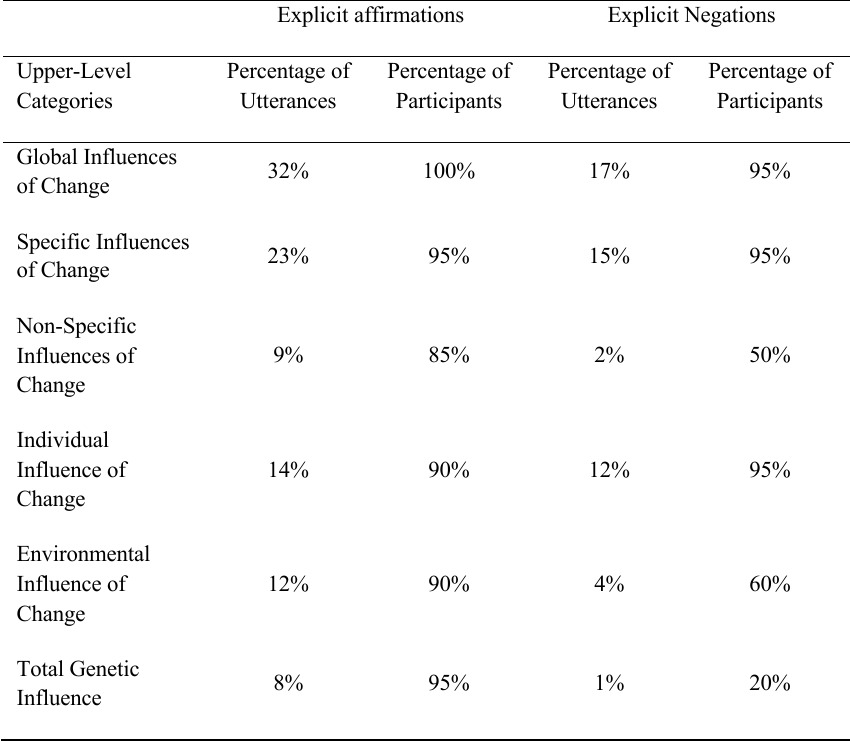
Upper-level categories. Dara related to the whole sample